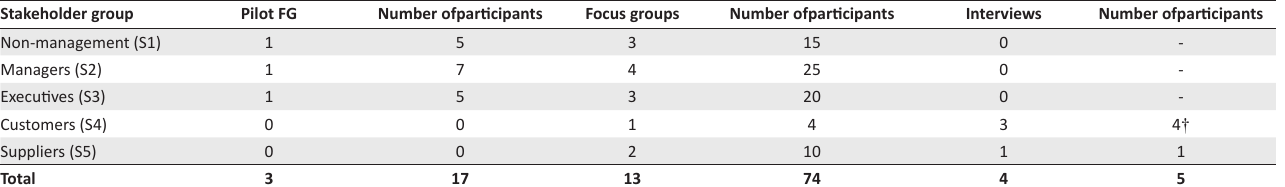
TABLE 1: Qualitative sample for phase 1. Stakeholder